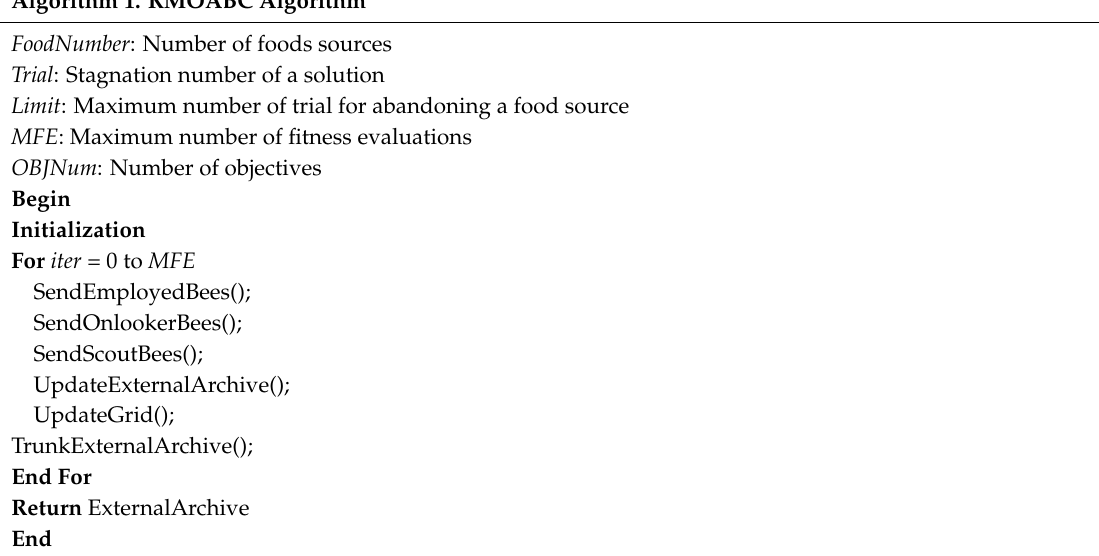
Algorithm 1. RMOABC